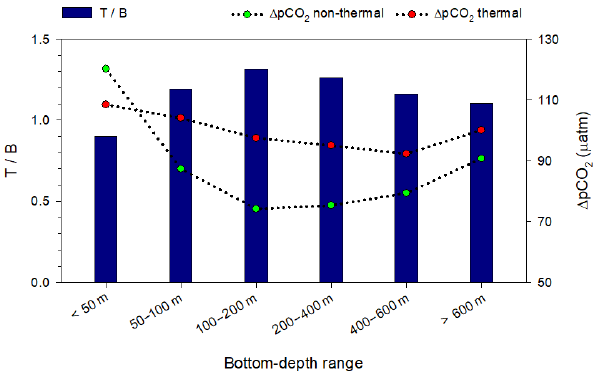
Figure 8. Variation of the T/B ratio (blue bar), non-thermal (cid:49)p CO 2 (green point) and thermal (cid:49)p CO 2 (red point) at differ- ent bottom-depth ranges of the water column (metres) for the eight cruises.